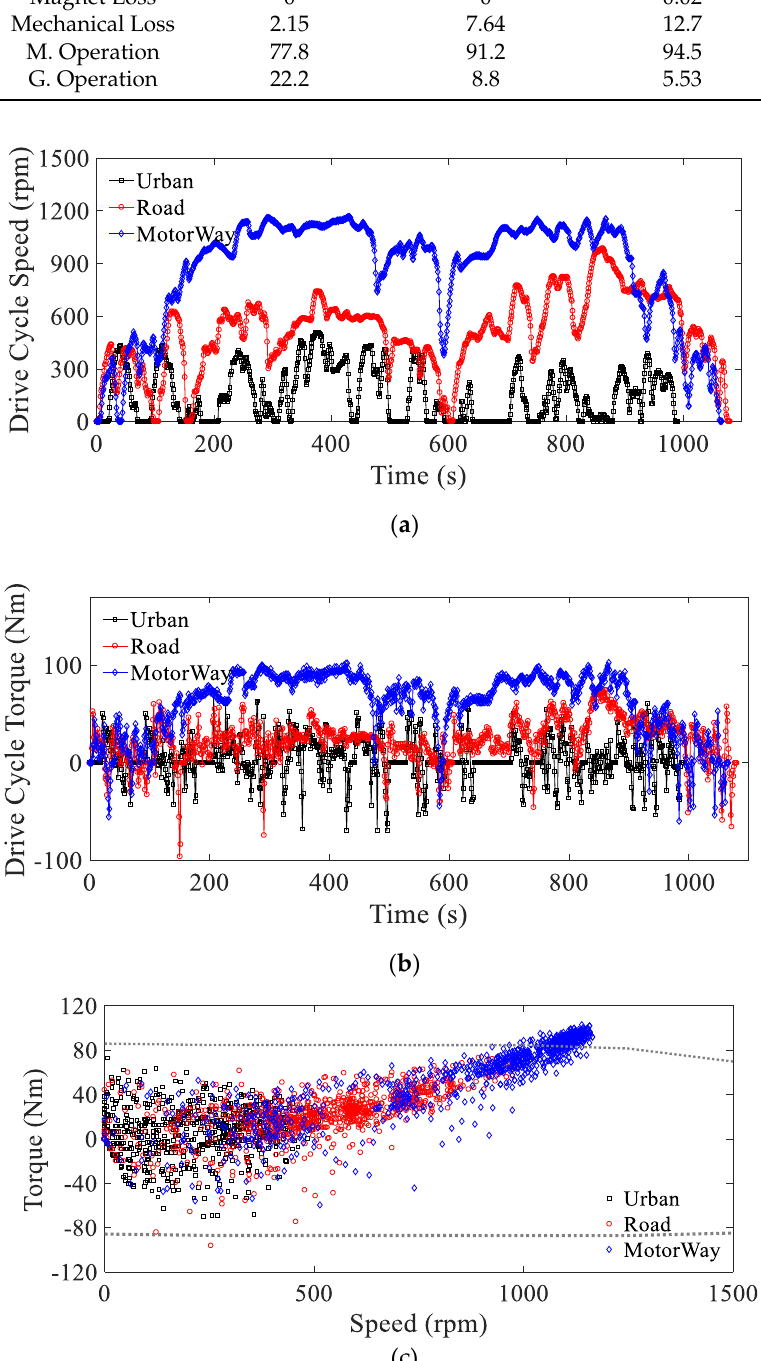
Figure 24. The Artemis DC of the Model-III: ( a ) speed, ( b ) torque, and ( c ) operational data points under Artemis DCs. Table 5. Artemis Drive-Cycle Data for the Model-III.